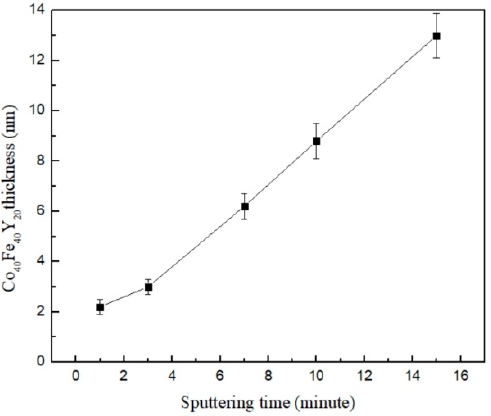
Figure 2. The corresponding thickness of associated sputtered time. AFM was used to observe the degree of fi lm coverage, which is shown in Figure 3a,b. From the result, the incomplete coverage of the 10 nm fi lm and the full coverage of the 40 nm fi lm can be shown by AFM. This result a ff ects the signi fi cant properties. Figure 3c–d exhibit AFM pro fi les of 10 nm and 40 nm across the fi lm edge, respectively.